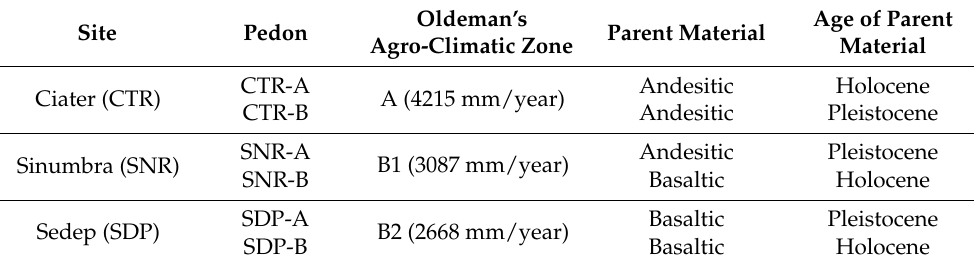
Table 1. Characteristics of each studied pedon in this research. Oldeman’s Age of Parent Site Pedon Parent Material Agro-Climatic Zone Material CTR-A Andesitic Holocene Ciater (CTR) CTR-B Andesitic Pleistocene Andesitic Pleistocene Basaltic Basaltic Pleistocene Sedep (SDP) SDP-B Basaltic